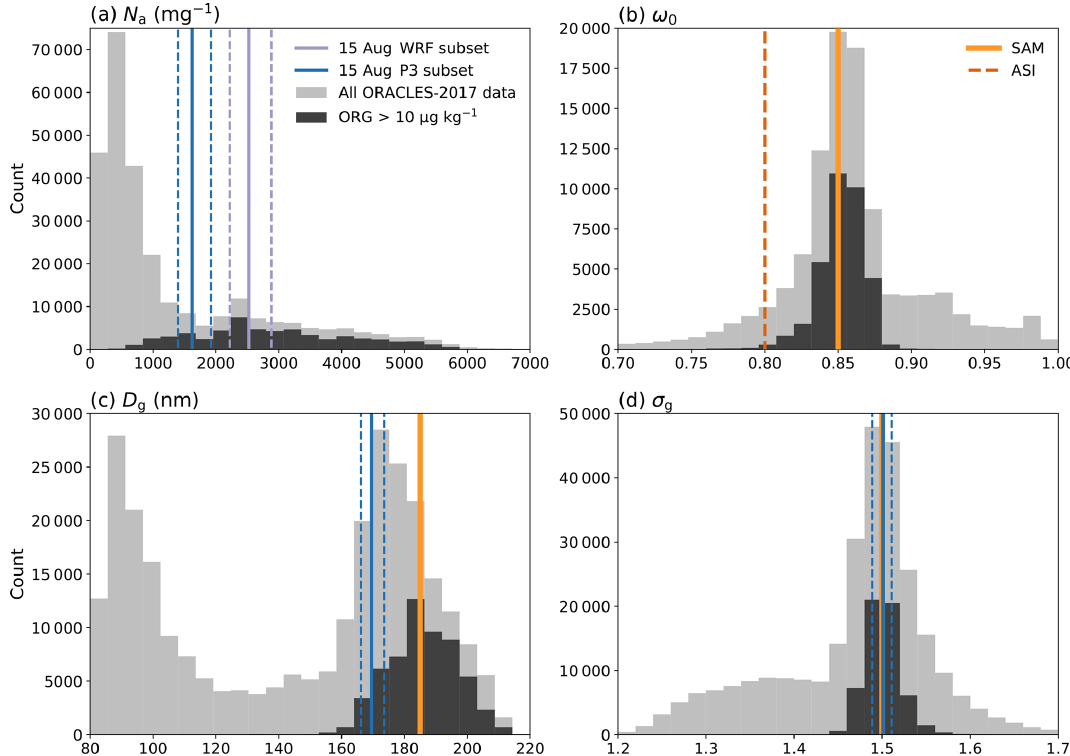
Figure 4. ORACLES-2017 flight statistics and assumed aerosol size distribution and optical properties for SAM. All flight data are repre- sented as light grey histograms and data with organic aerosol concentrations (ORG) greater than 10µgkg − 1 as dark grey histograms for (a) aerosol number concentration, (b) dry single-scatter albedo at 550nm, and the (c) geometric mean diameter and (d) geometric standard devi- ation of the aerosol size distribution. Blue solid and dashed lines denote mean and interquartile values, respectively, for the 15 August 2017 flight between 11:00 and 13:00UTC for ORG > 10µgkg − 1 . The purple solid and dashed lines in panel (a) denote the mean and interquartile values, respectively, of the WRF-CAM5 FireOn aerosol number concentration subset along the P3 flight track from 11:00 to 13:00UTC on 15 August 2017 for ORG > 10µgkg − 1 . Values selected for use in the standard SAM aerosol representation are shown as gold lines. The dashed orange line in panel (b) represents the average single-scatter albedo value observed during the LASIC campaign (ASI) for August